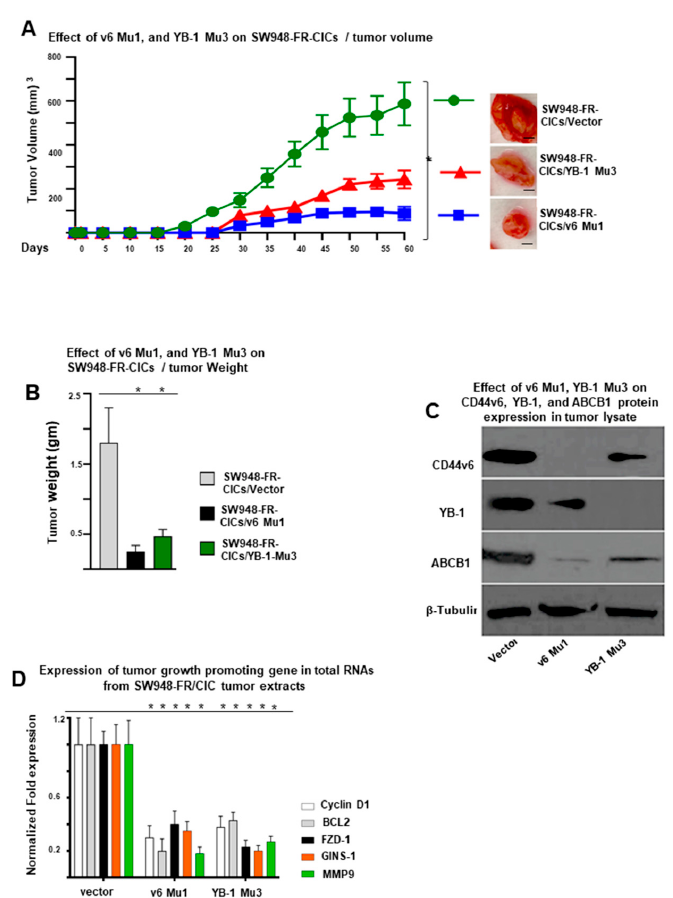
Figure 7. Role of CD44v6 in the SQ tumorigenesis of SW948-FR/CICs in vivo. ( A , B ) Effects of CD44v6, or YB-1, or a combination of CD44v6 + YB-1 knockout on tumor growth in nude mice are shown. CD44v6 Mu1, YB-1 Mu3, or v6 Mu1 + YB-1 Mu3 knockout FOLFOX resistant CRC CICs and wide-type CICs were injected into nude mice. The tumor volumes in mice were measured every five days ( A ). Sixty days later, the mice were sacrificed. A solid tumor was collected from each mouse. ( B ) The impacts of v6 Mu1, YB-1 Mu3 knockout FOLFOX resistant CRC CICs on tumor weights are shown. ( C ) The CD44v6, MDR1, and YB-1 protein levels in tumors of mice injected with v6 Mu1, YB-1 Mu3 knockout FOLFOX resistant CRC CICs or WT CICs are shown. β -Tubulin was used as an internal control. ( D ) Expressions of proliferation/antiapoptosis/invasion/stemness related genes (by QPCR) in these solid tumors are shown. Data are presented as mean ± SD ( n = 7); * p < 0.05. ANOVA followed by Bonferroni’s post-hoc test was used to assess the significance. Western blot data are representative of three experiments. QPCR data are presented as mean ± SD ( n = 4); * p < 0.05. Scale bar, 50 µm.